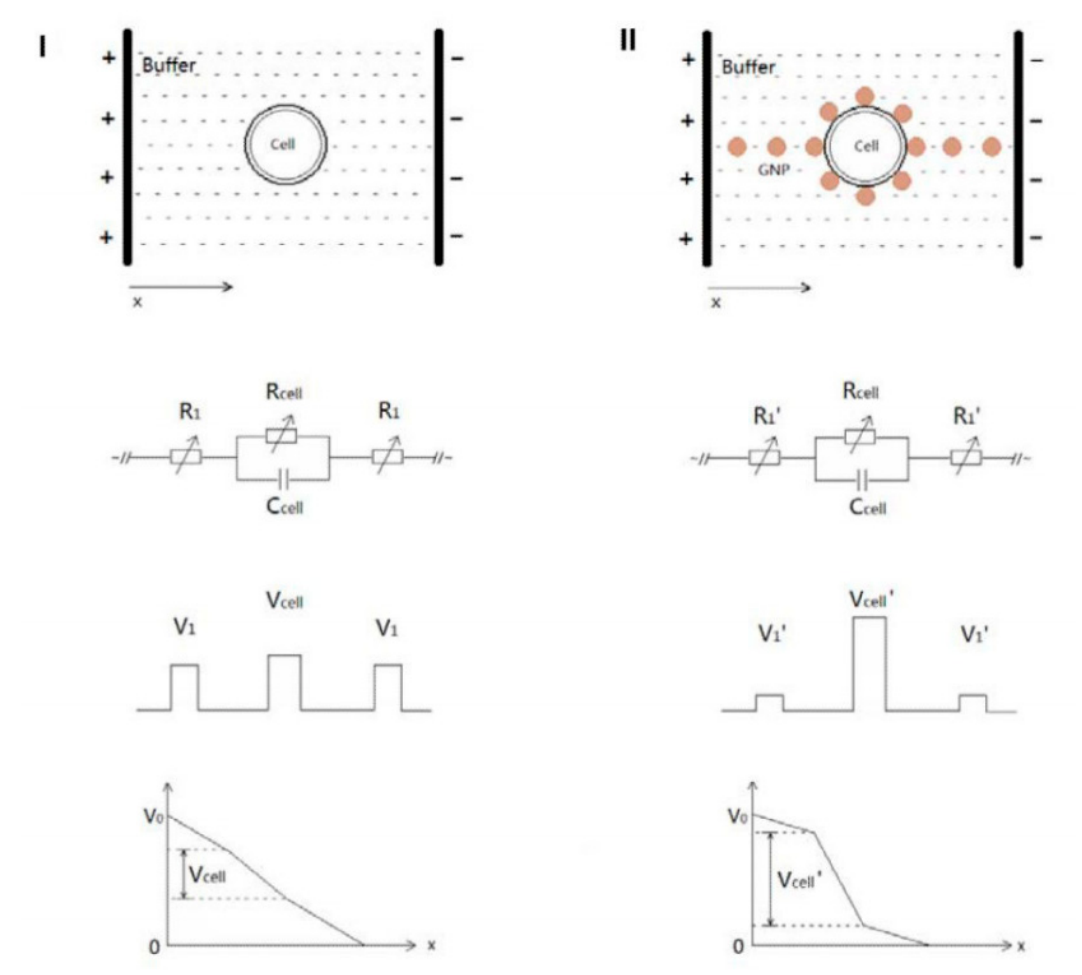
Figure 12. Differential of potential in a biological environment without metallic NPs ( left ) and with NPs ( right ). Reprinted from “Gold nanoparticles enhanced electroporation for mammalian cell transfection.” J. Biomed . Nanotechnol . 2014, 10, 982–992, Figure 1” [146].